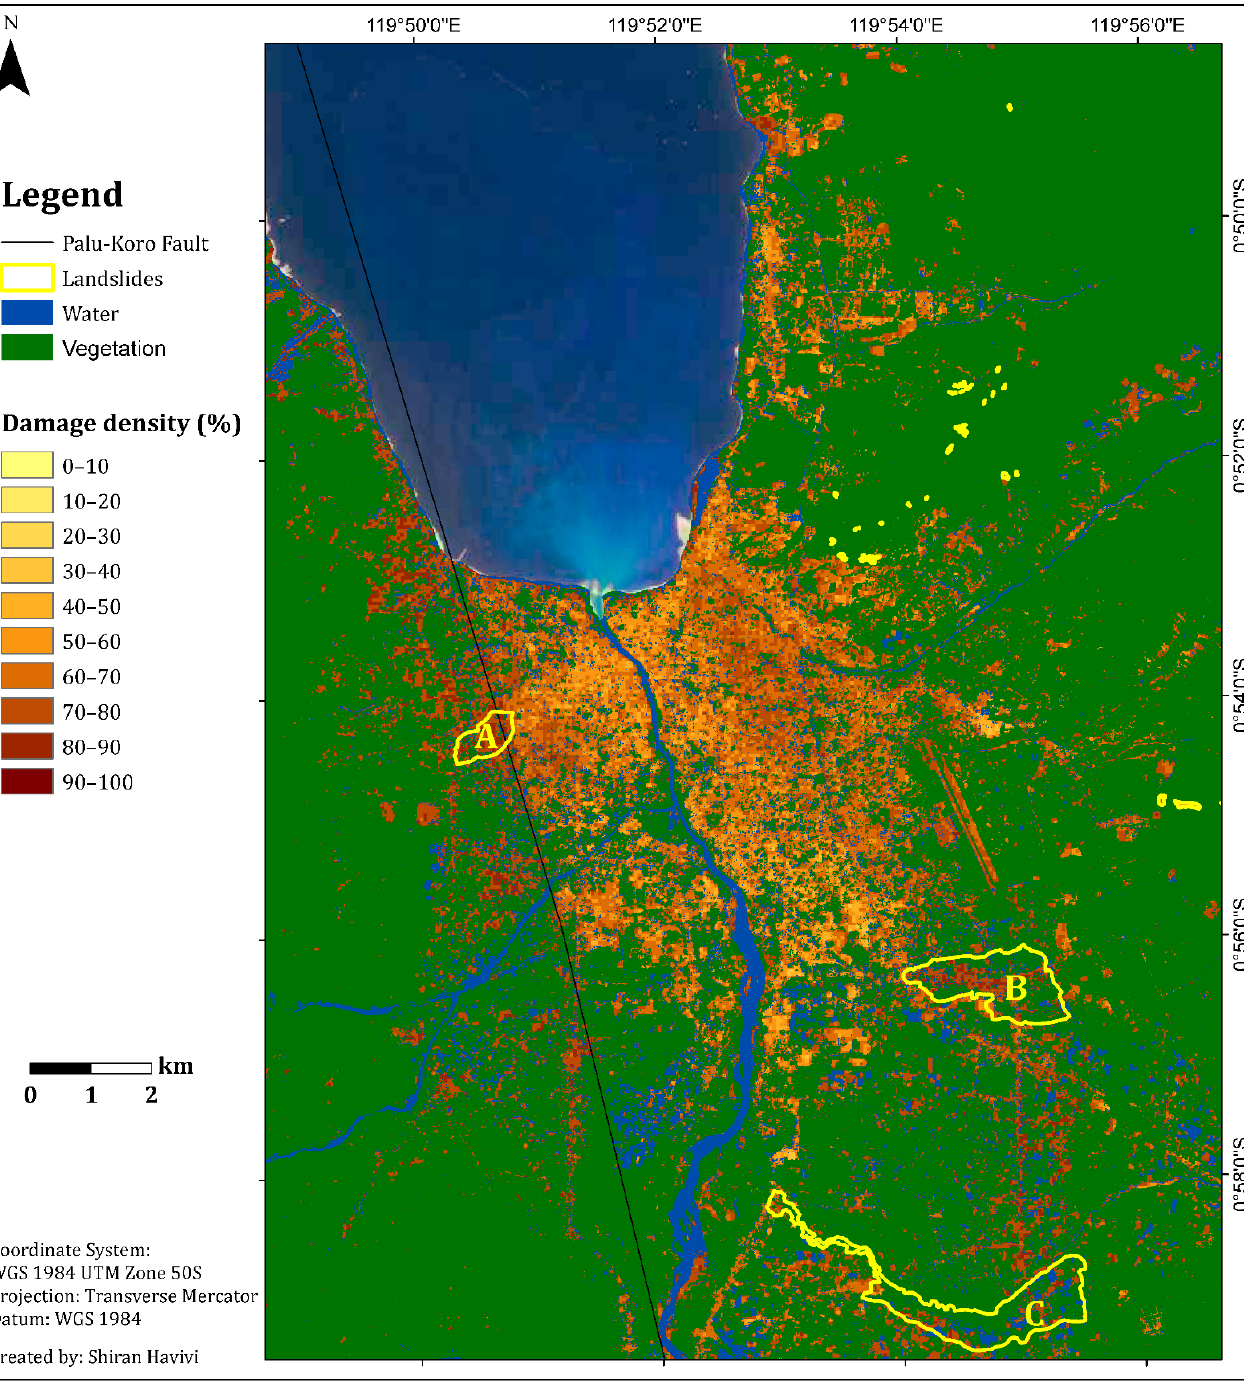
Figure 5. Damage density map per unit area of 50 m. Light colors represent a lower probability of damage, dark colors represent a higher probability of damage. Green represents vegetation. Blue represents water bodies. The black line represents the Palu-Koro Fault. Flow slide areas are outlined in yellow: ( A ) Balaroa ( B ) Petobo, and ( C ) Jono Oge.